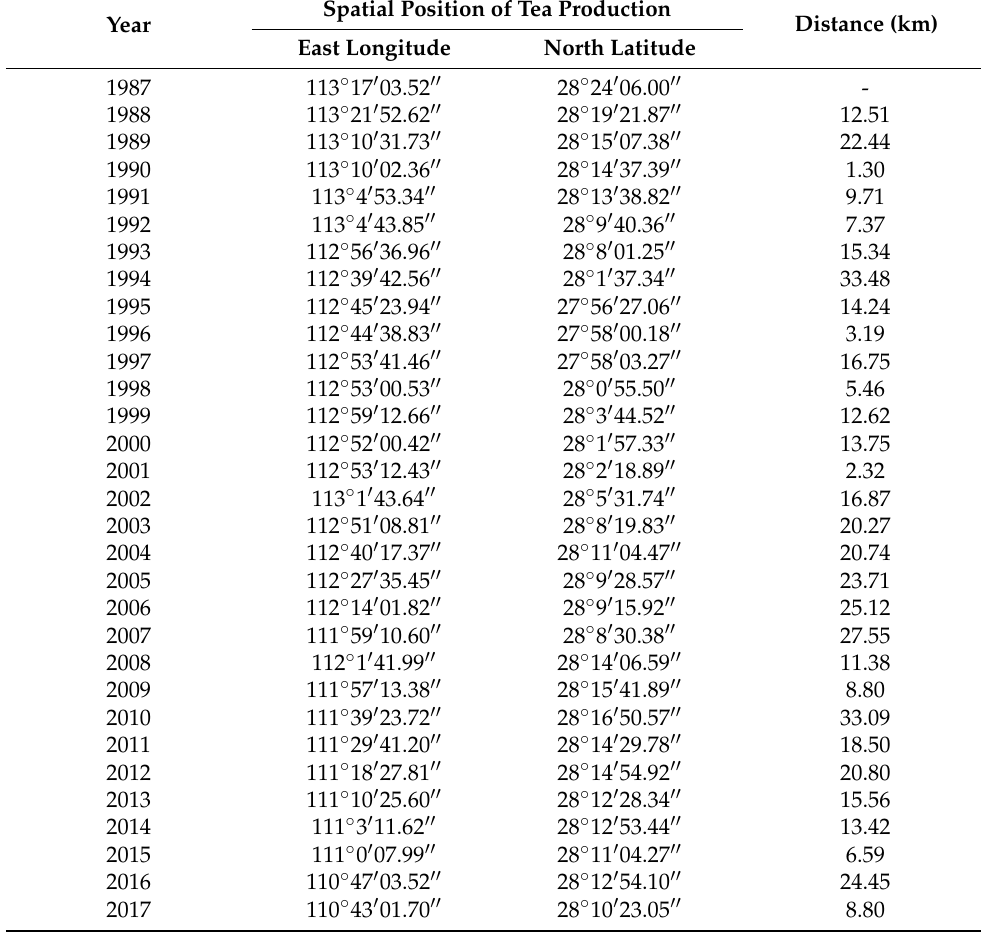
Table A3. Moving Distance of Economy Gravity Center in China from 1987 to